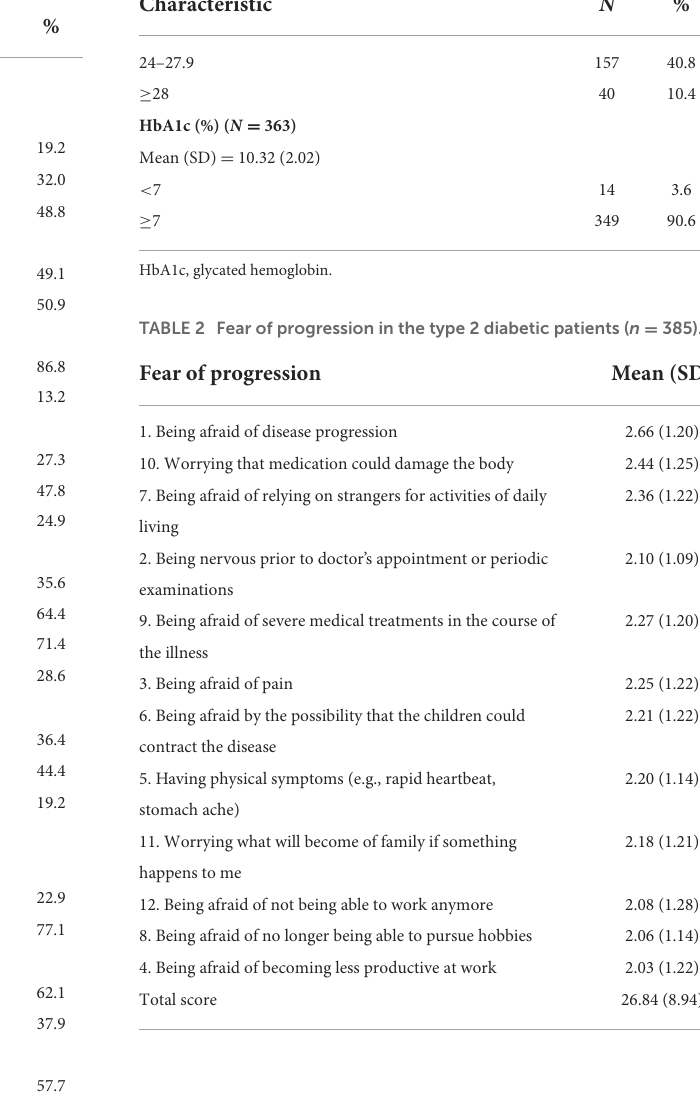
TABLE 1 Socio-demographic and clinical characteristics of the type 2 diabetic patients ( n = 385).